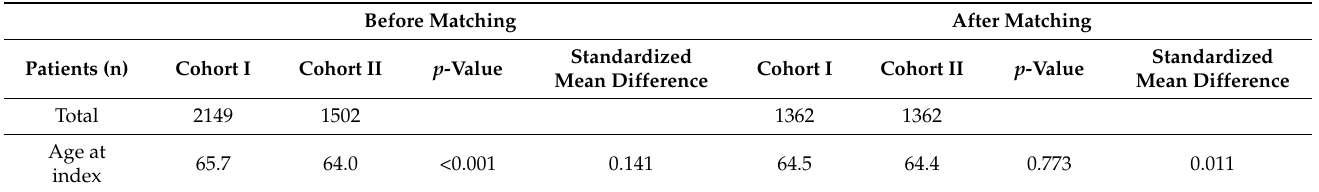
Figure 1. Modified Consort flow diagram. ICD-10: International Classification of Diseases 10, C00-14: malignant neoplasms of lip, oral cavity and pharynx. Table 2. Characteristics of cohorts I (individuals with ICD-10 codes C00-14 and no antibiotics) and II (with antibiotics) before and after matching for age and sex, BMI, secondary lymph node metastases, tobacco use and feeding device. ICD-10 = International Classification of Diseases.